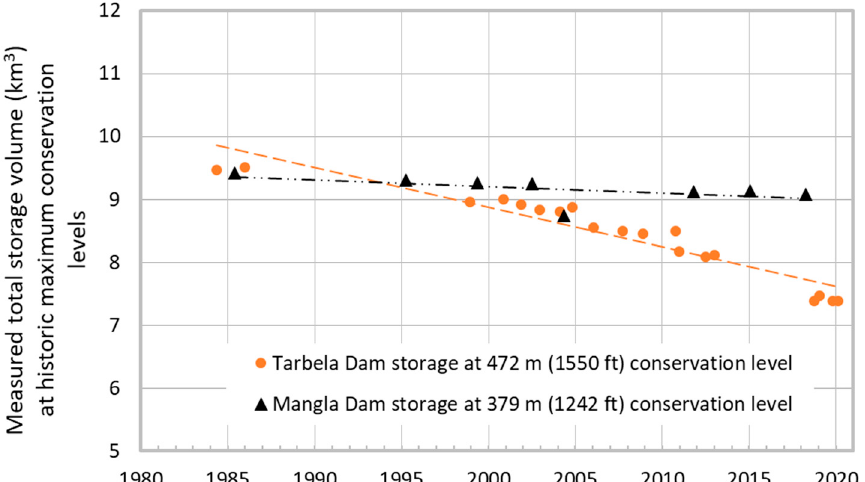
Figure 5. The observed sedimentation of Tarbela and Mangla storages through time. Data source: Water and Power Development Authority (WAPDA) [37].